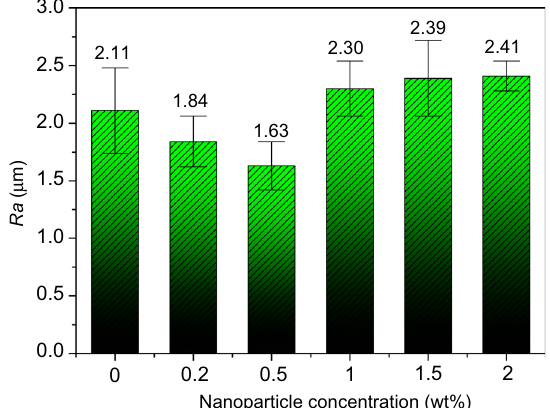
Figure 4 Surface roughness under different nanoparticle concentrations